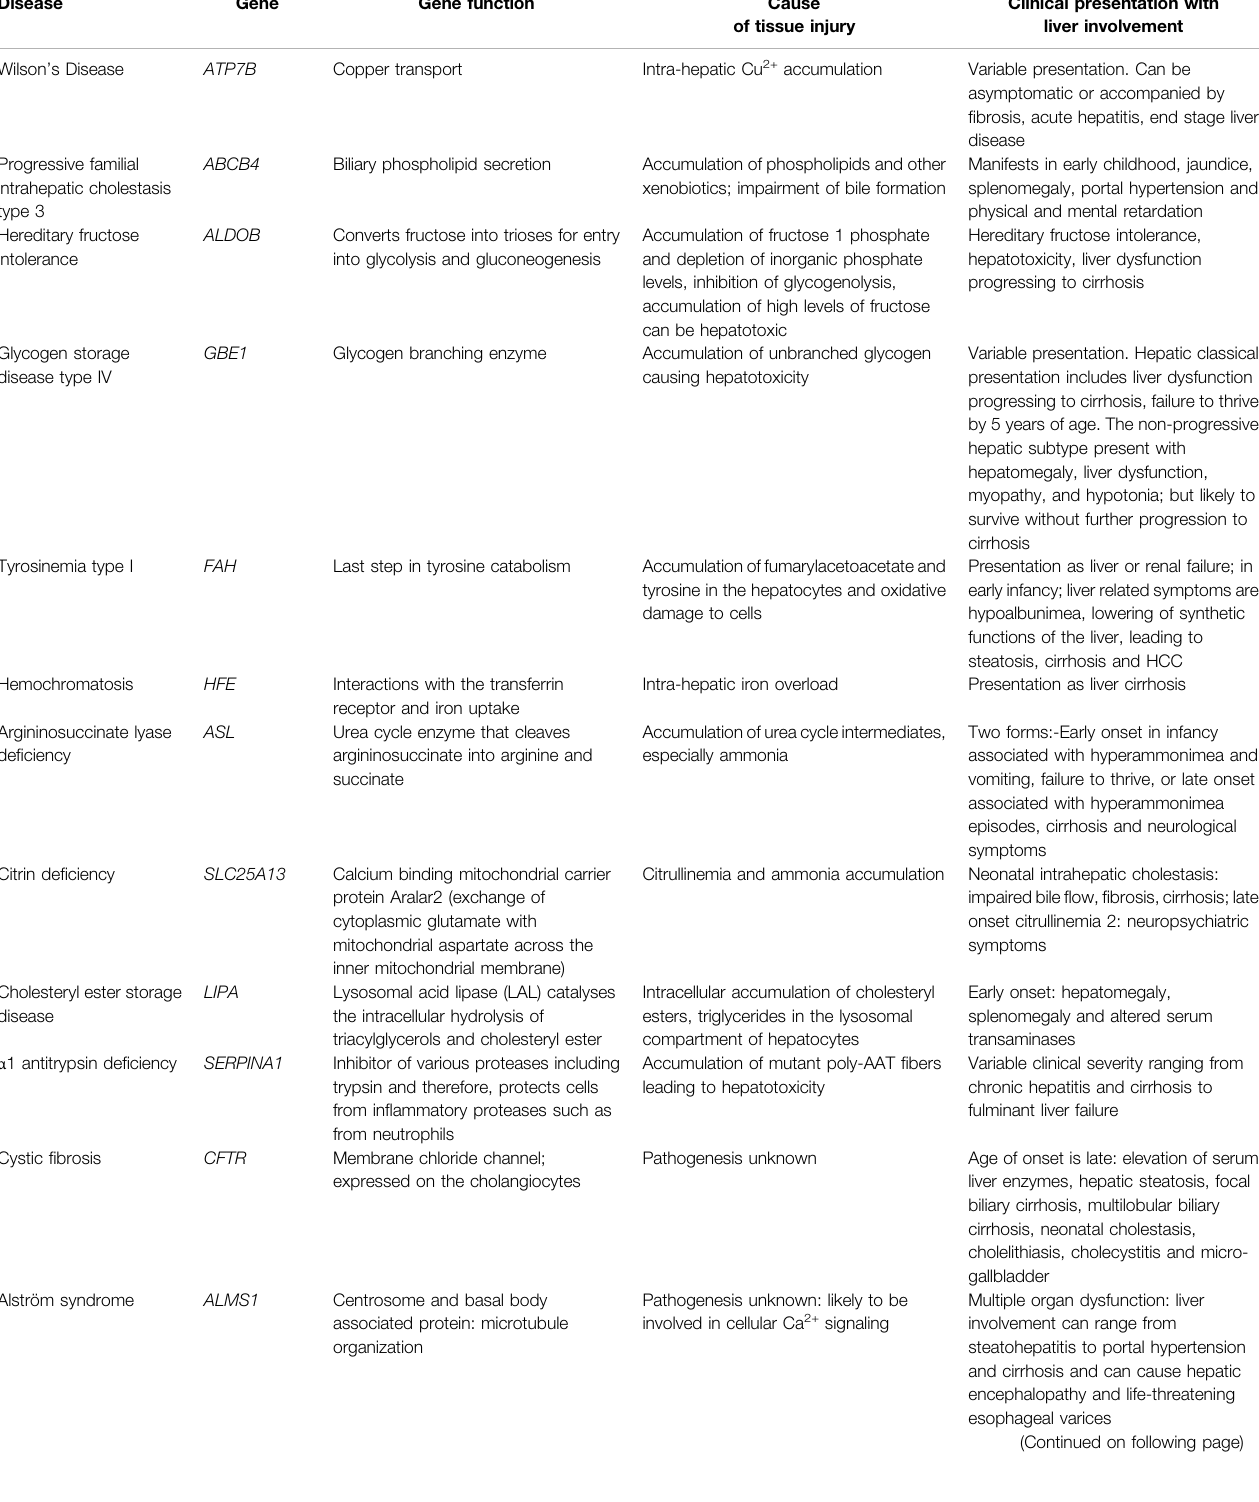
TABLE 1 | Genetic causes predisposing the liver to fi